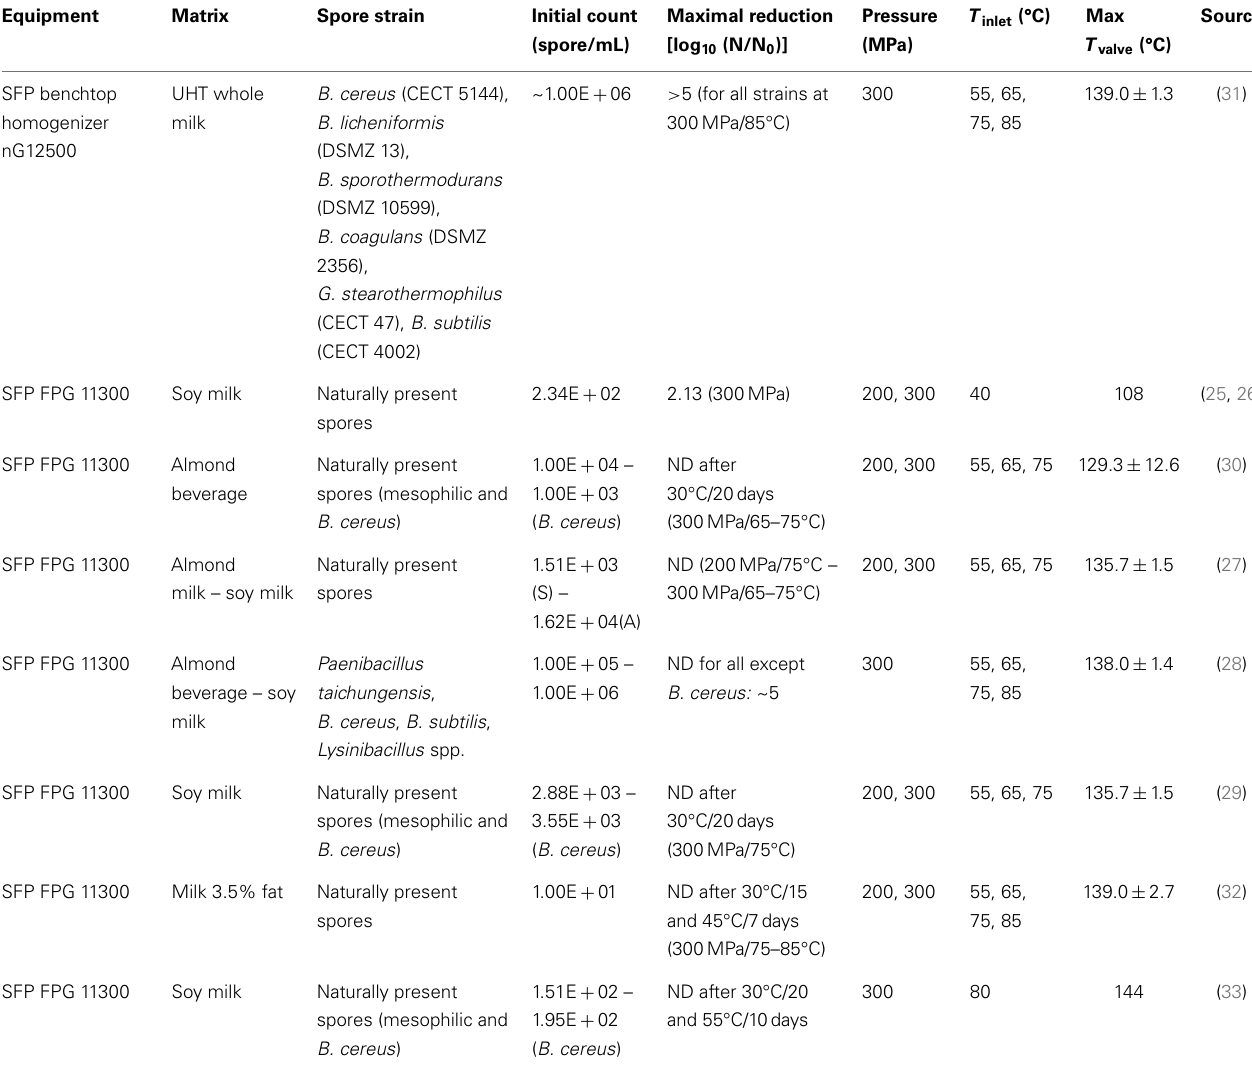
Table 2 | Overview of literature on successful HPH/UHPH inactivation of bacterial spores